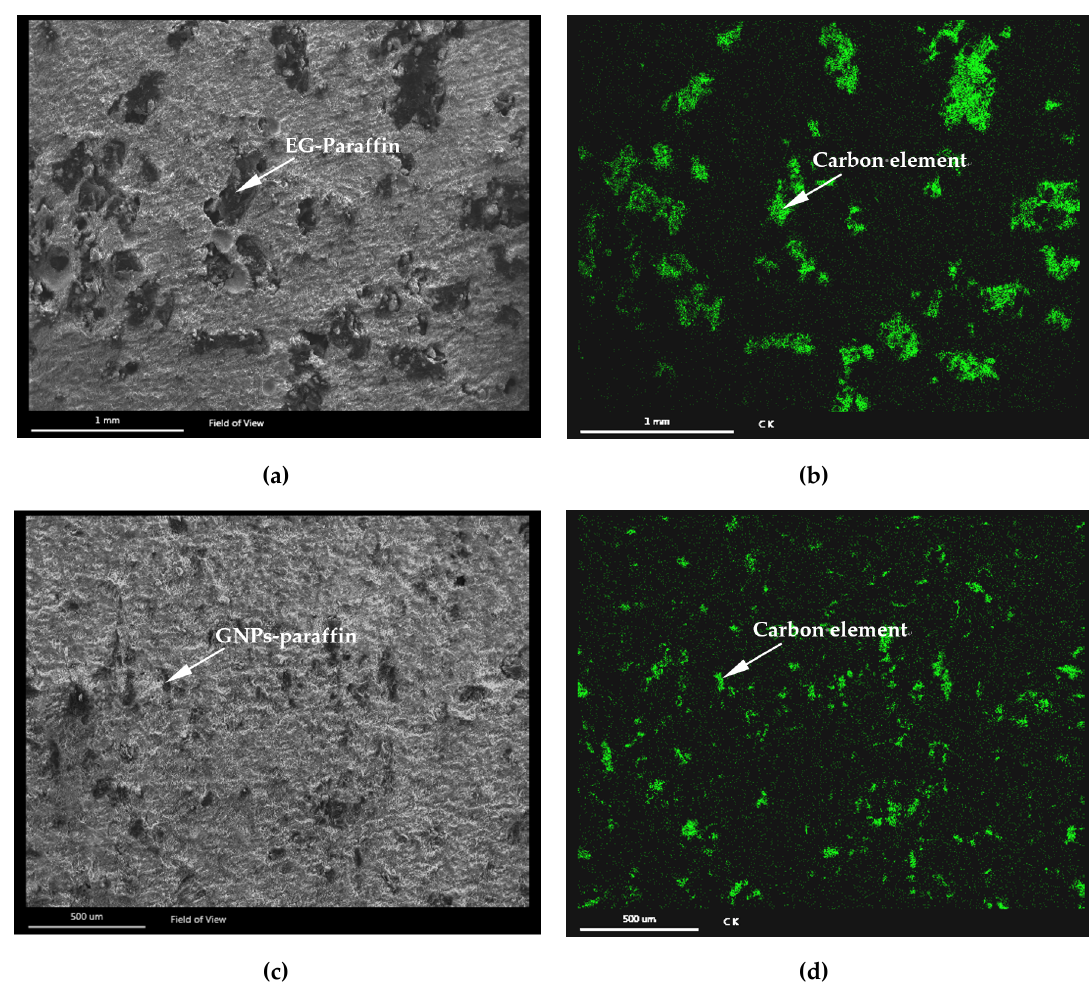
Figure 4. SEM image of cement paste containing two different phase change materials (PCMs): ( a ) cement paste containing 10% of EG ‐ Paraffin; ( b ) EDS for EG10; ( c ) cement paste containing 10% of GNPs ‐ paraffin; ( d ) EDS for GNPs10. (Carbon elements are shown in green).